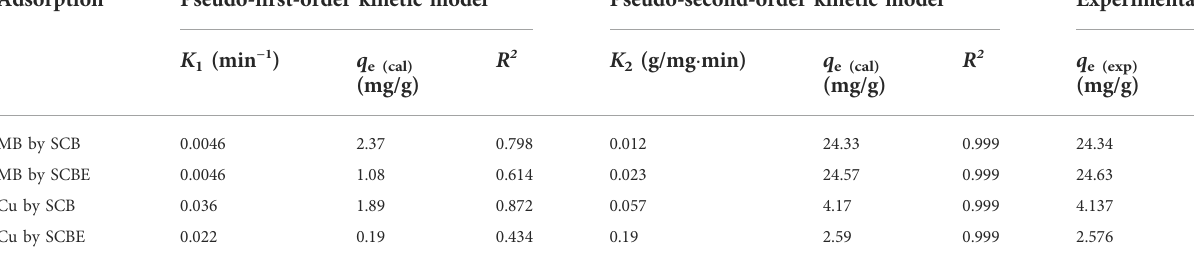
TABLE 1 Kinetic parameters for MB dye and Cu 2+ adsorption by SCB or SCBE. Adsorption Pseudo- fi rst-order kinetic model